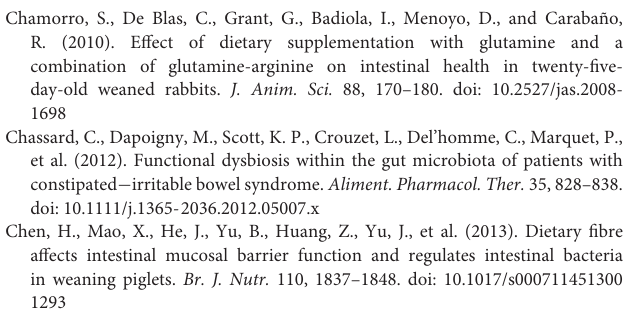
FIGURE S1 | Dietary Gly-Gln supplementation improved jejunum morphology. Morphology of jejunum epithelium (H&E) at a magnification of 40 and 200 on day 38 and day 49. TABLE S1 | Ingredients and nutrients composition of the basal diet offered to piglets. TABLE S2 | Villus height, crypt depth and villus height/crypt depth ratio in the jejunum of piglets. TABLE S3 | Growth performance parameters of